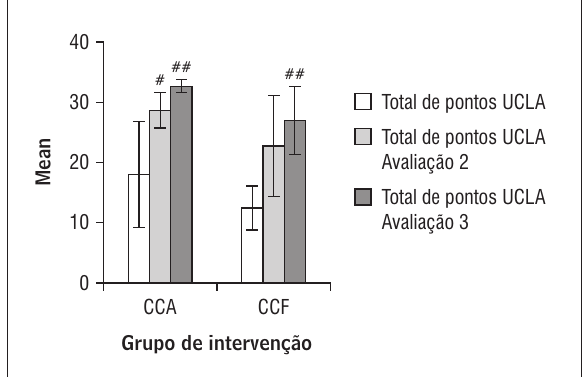
Figura 2 - Análise dos pontos da escala de Constant ambos os